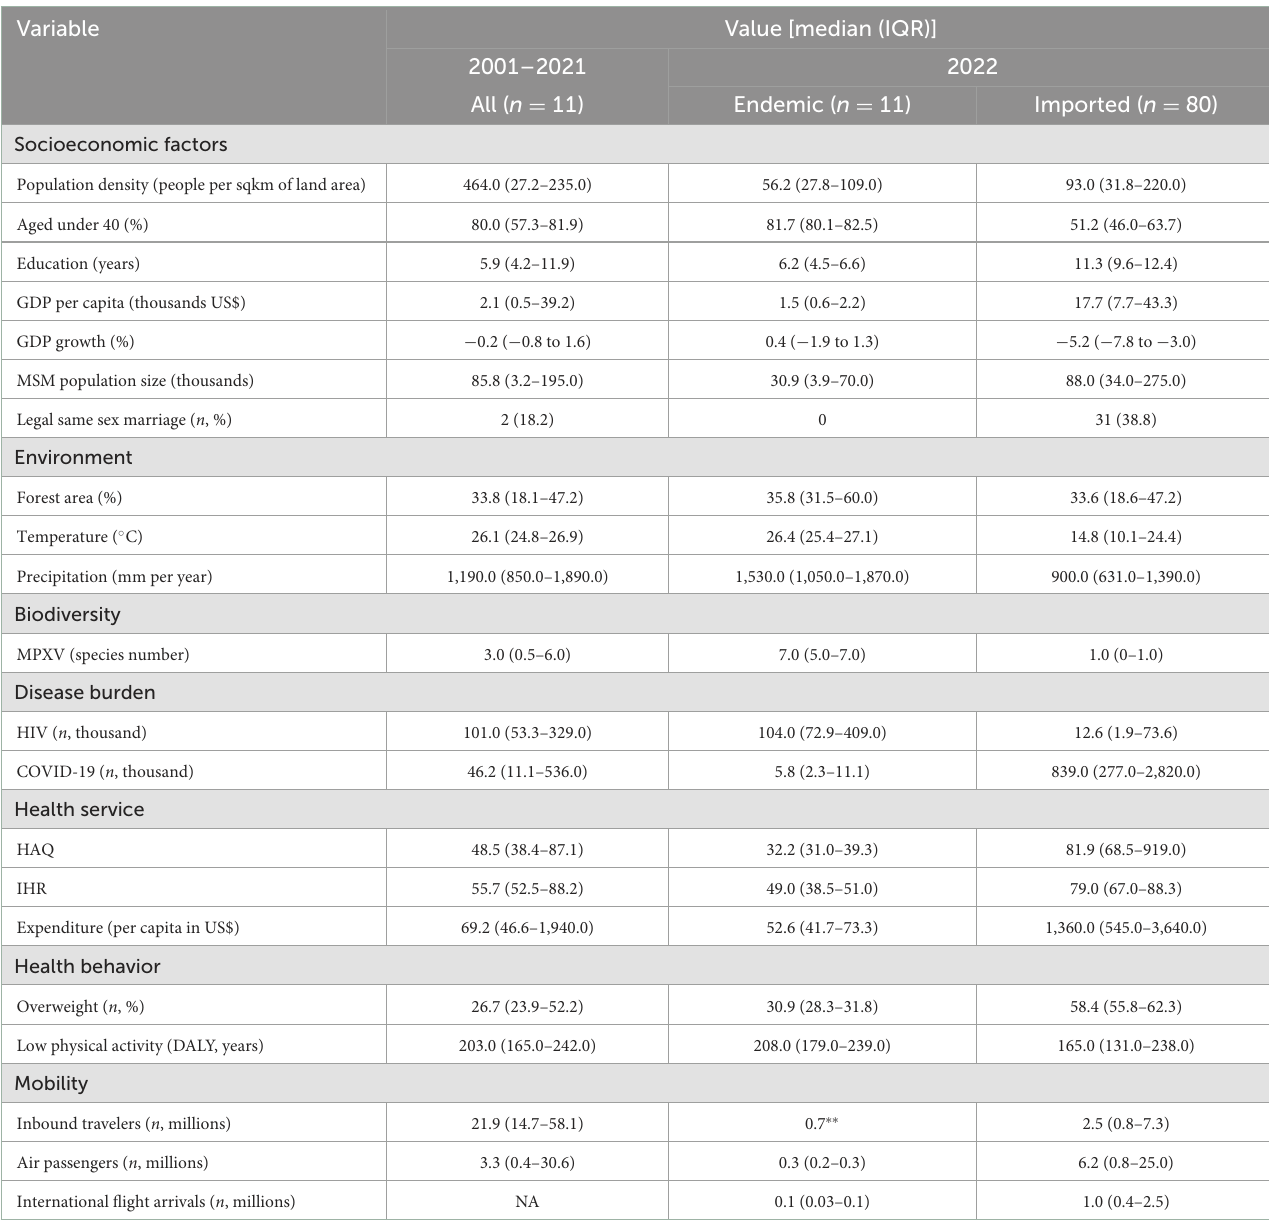
TABLE 1 List of variables used in this study ∗